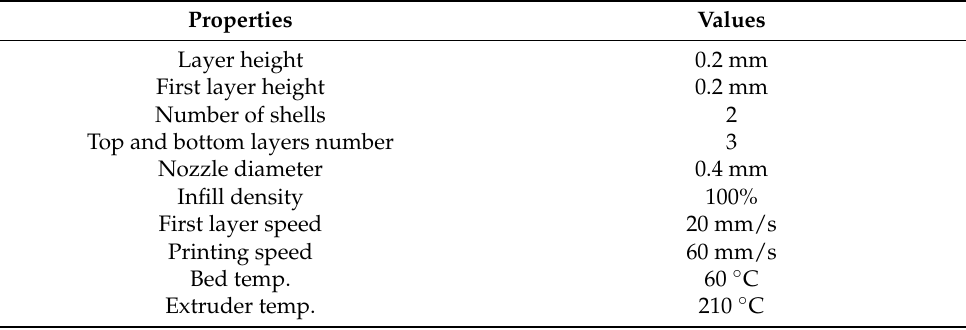
Table 2. Process parameters for sample